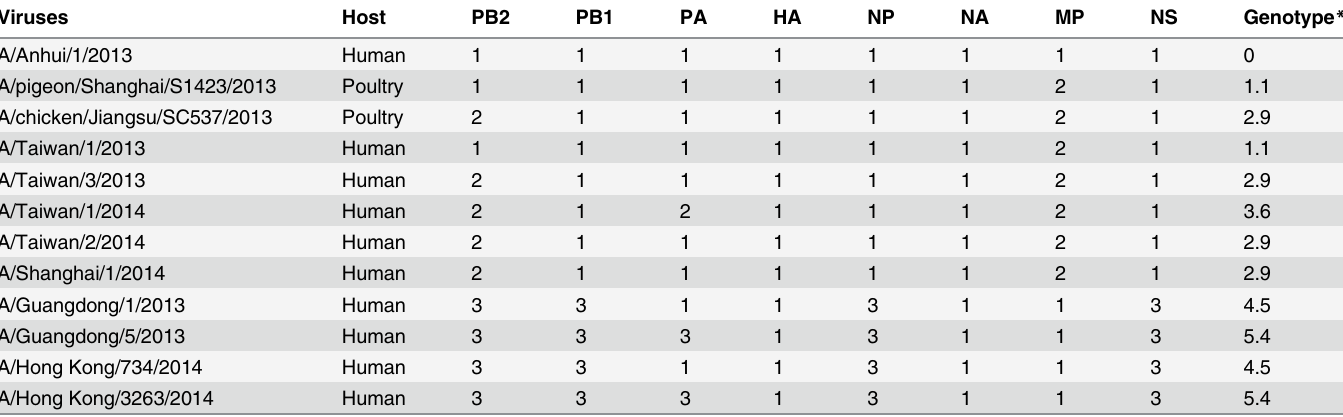
Table 2. Genotyping of the four imported H7N9 viruses of Taiwan.